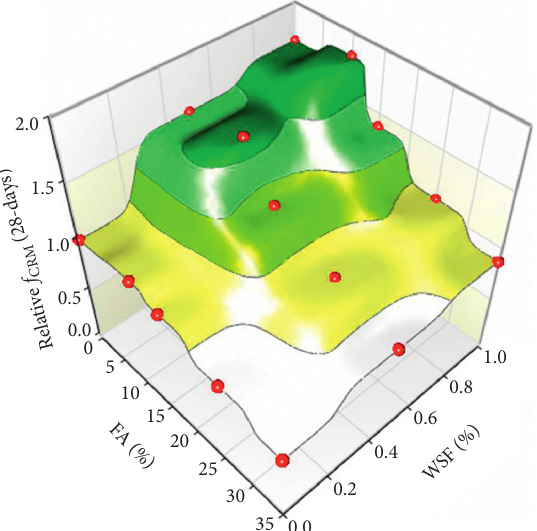
Figure 16: Relationship between WSF and FA contents and relative f CRM